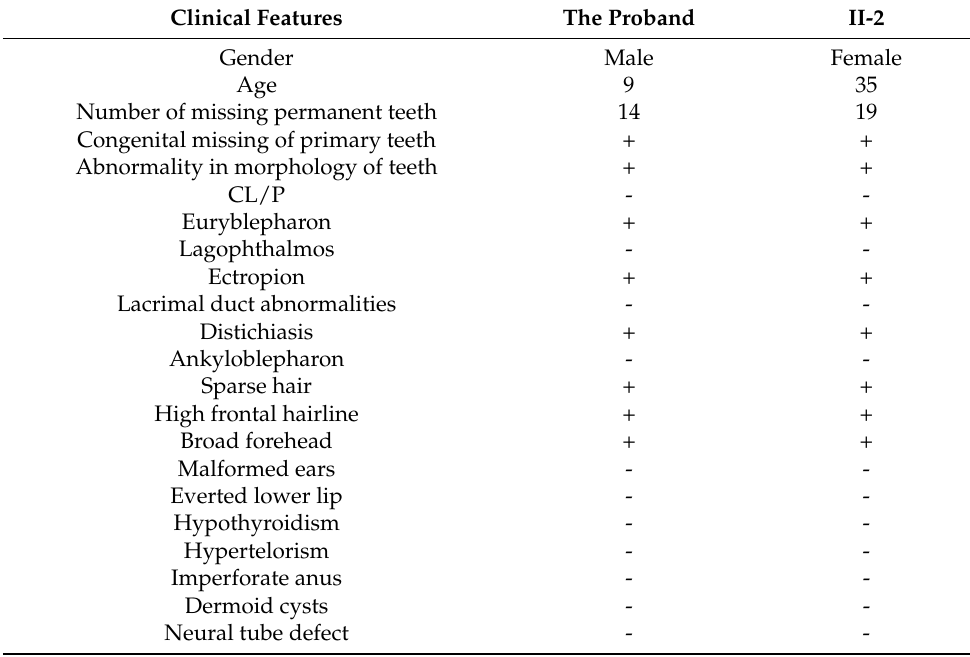
Table 1. Clinical features of patients in this